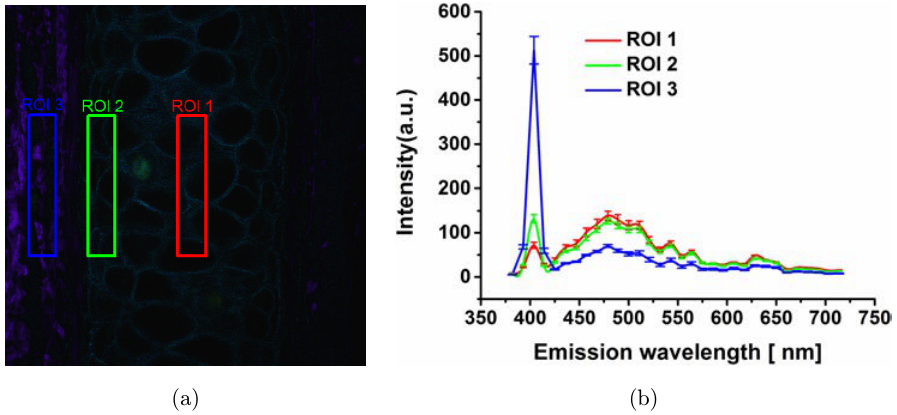
Fig. 4. (a) Spectral resolved TPEF/SHG image and (b) emission spectra obtained from the center region (red rectangle-enclosed region, ROI 1), peripheral region (green rectangle-enclosed region, ROI 2), and the perichondrium region (blue rectangle-enclosed region, ROI 3) of elastic cartilage. The excited wavelength (cid:2) ex ¼ 810